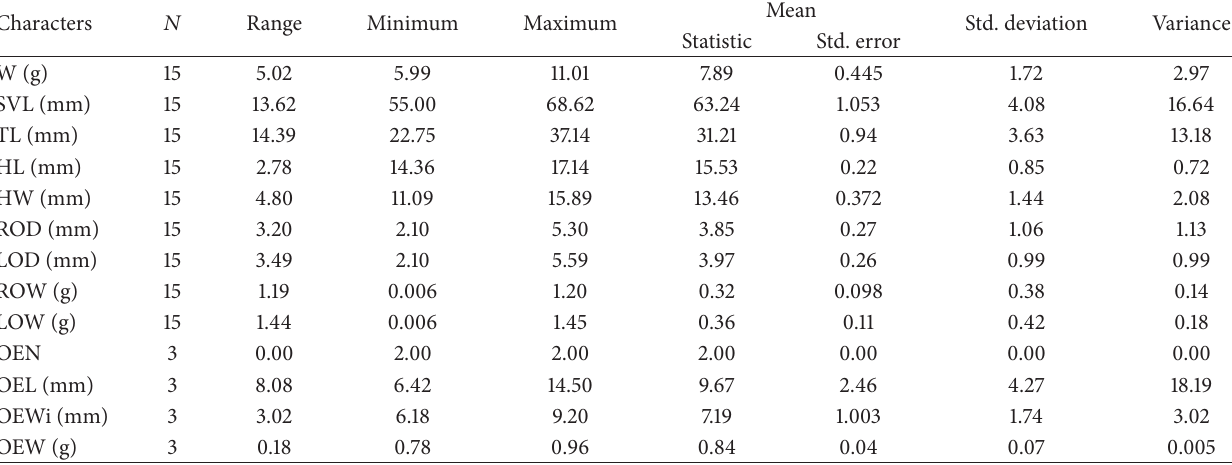
Table 1: Descriptive statistics of macroscopic characters in T . bedriagai (for abbreviations, see Materials and Methods section).